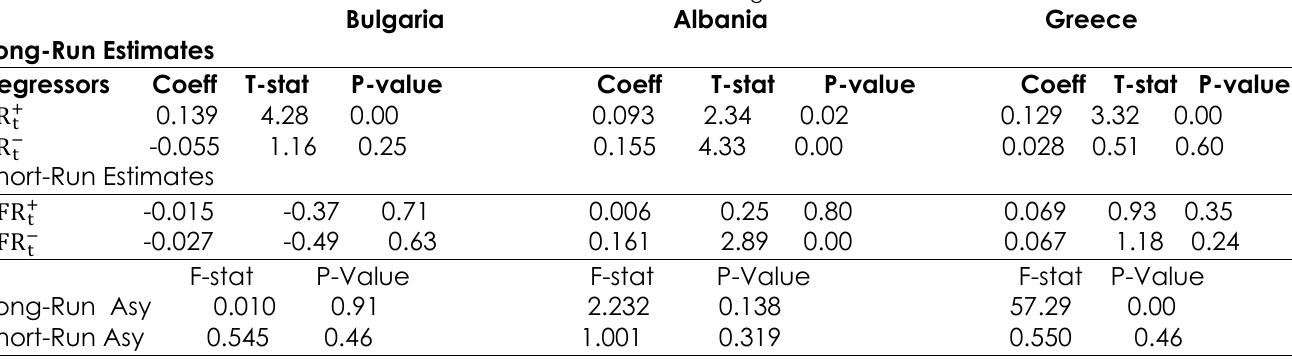
Table 3: NARDL Estimation for the Balkan Countries where Financial Risk is the Regressor.